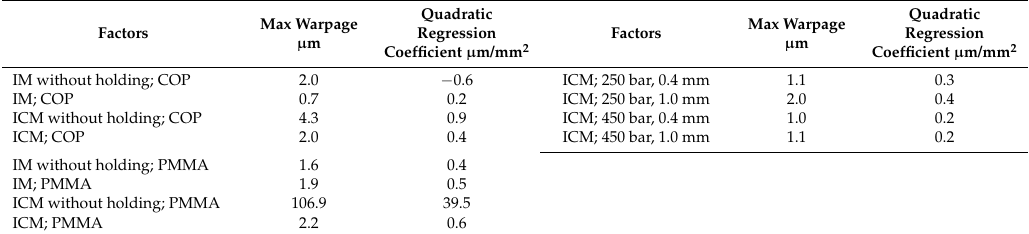
Table 6. Results summary of part warpage as the maximum absolute deviation in the evaluated area, and as a quadratic coefficient of regression of the evaluated residuals.